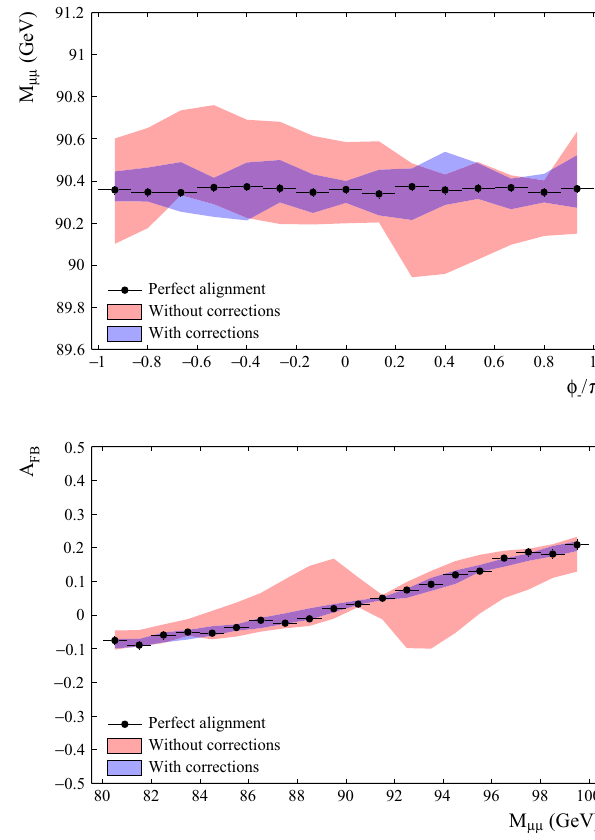
Fig. 8 Profiles of the mean dimuon invariant mass in bins of φ + , φ − and φ d , and the A FB values in bins of mass. The black points corre- spond to the simulation before any mis-alignment. The red (blue) band representsthevariationsovertentoyexperimentswiththe100 μ m inco-